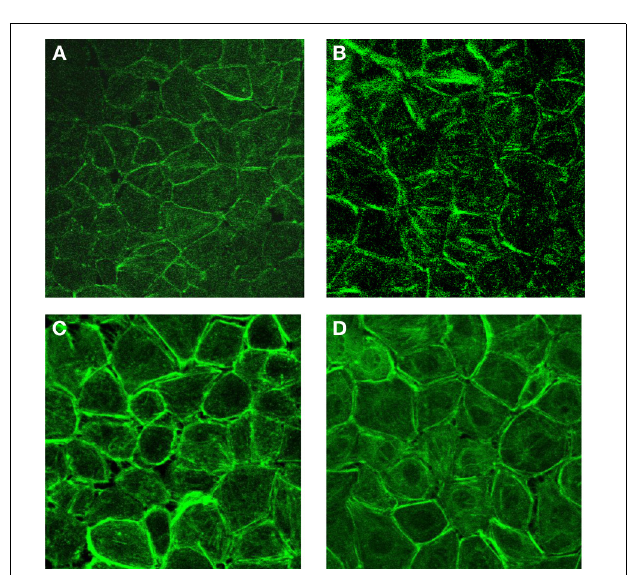
component in fura 2 loaded pleural mesothelial cells. Each tracing is a representative of 5 independent experiments. (B) Dose-response curves showing magnitude of initial transient increase in [Ca 2 + ] i in rat pleural mesothelial cells. Each point represent mean ± SD of 5 ∼ 7 separate experiments.